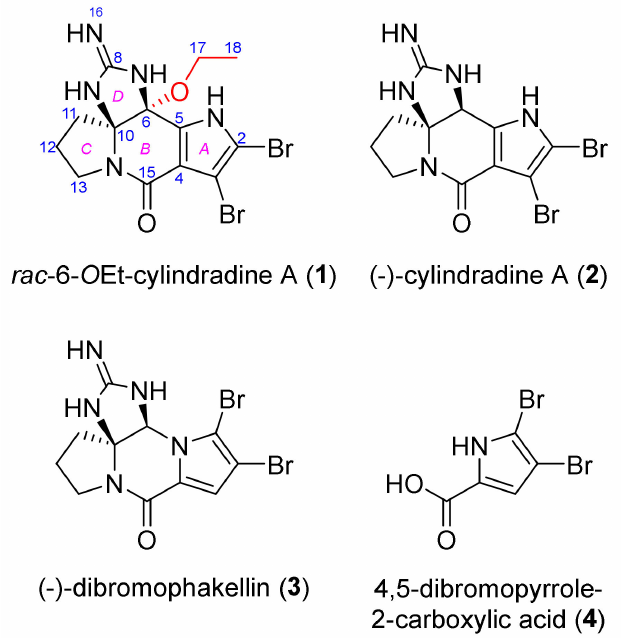
Figure 1. The chemical structures of a new unnatural derivative of alkaloid ( 1 ) and naturally occurring compounds ( 2 – 4